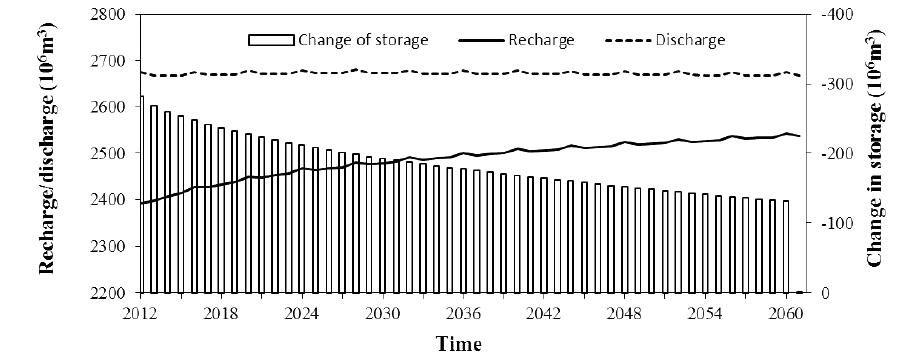
Figure 3. Change of groundwater balance under scenario